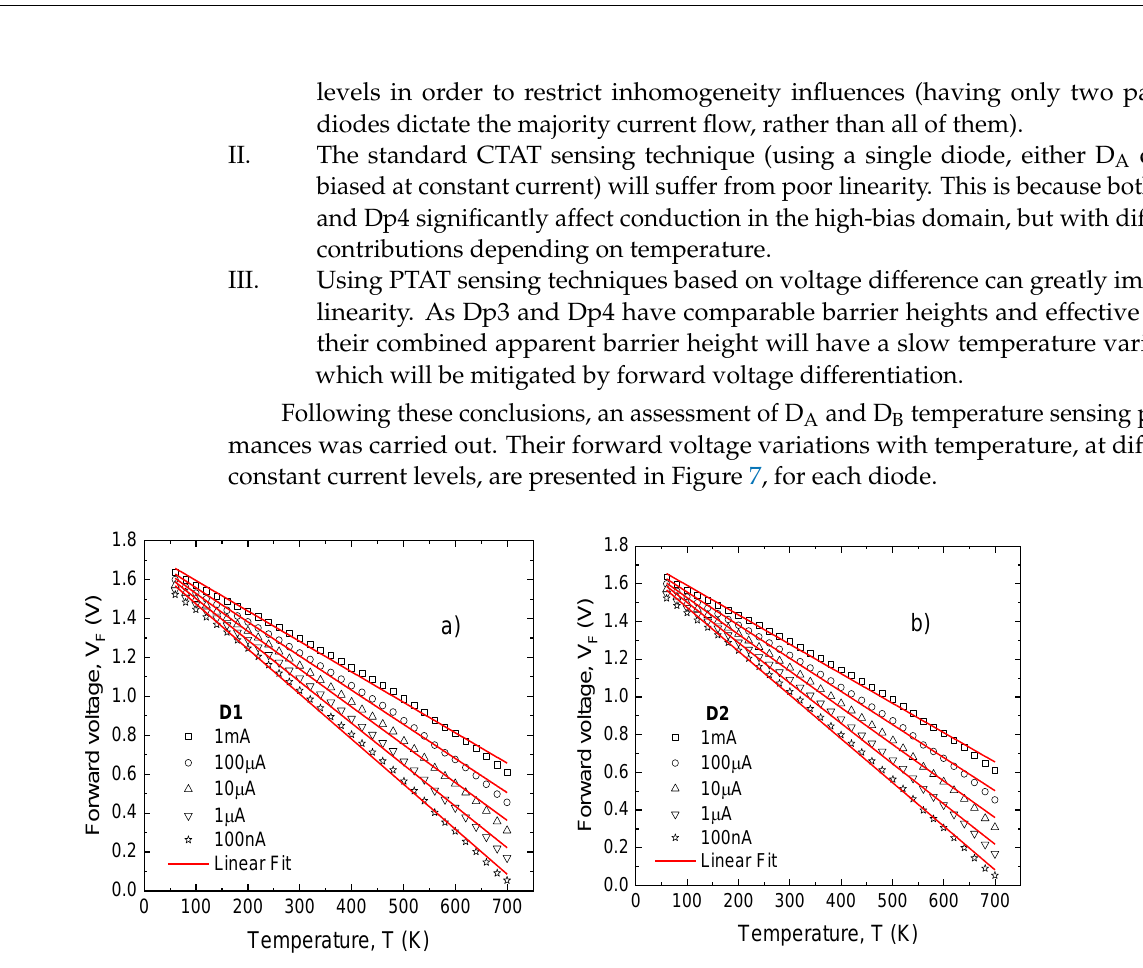
Figure 7. Forward voltage as a function of temperature for ( a ) D A and ( b ) D B at several bias currents.